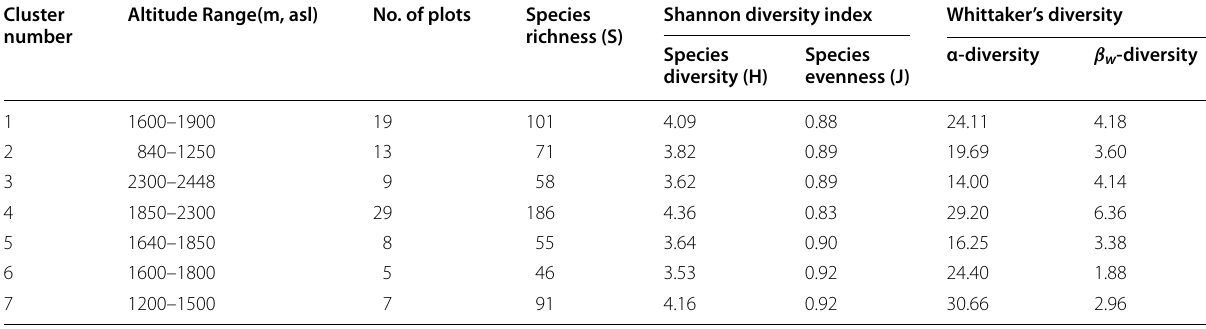
Table 3 Diversity analysis for each of the seven plant community types in Sele-Nono Forest Cluster Altitude Range(m, asl) No. of plots Species number